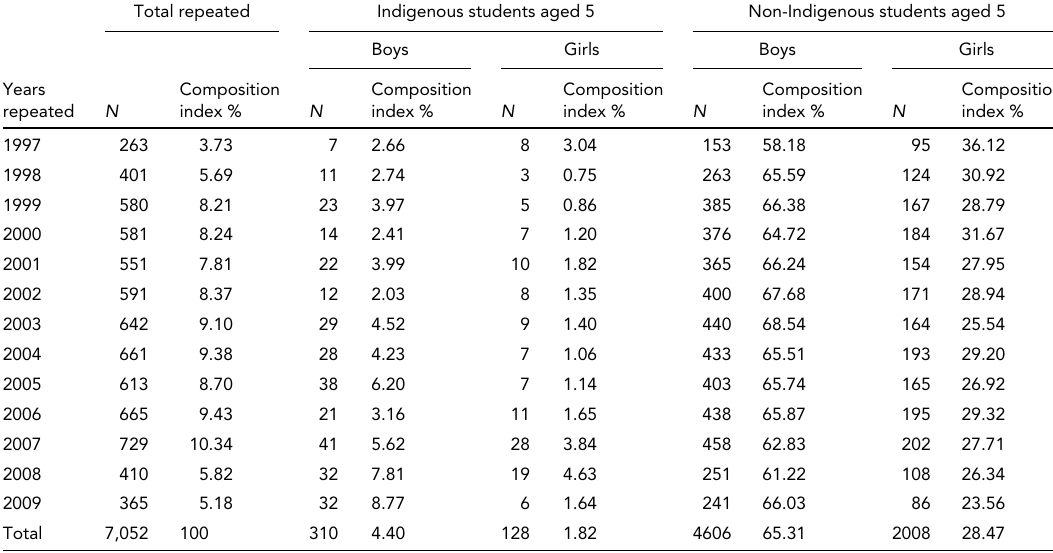
Composition Indexes of Repeated Indigenous and Non-Indigenous Students, Boys and Girls, Aged 5 years in Queensland State Schools From 1997 to 2009 Total repeated Indigenous students aged